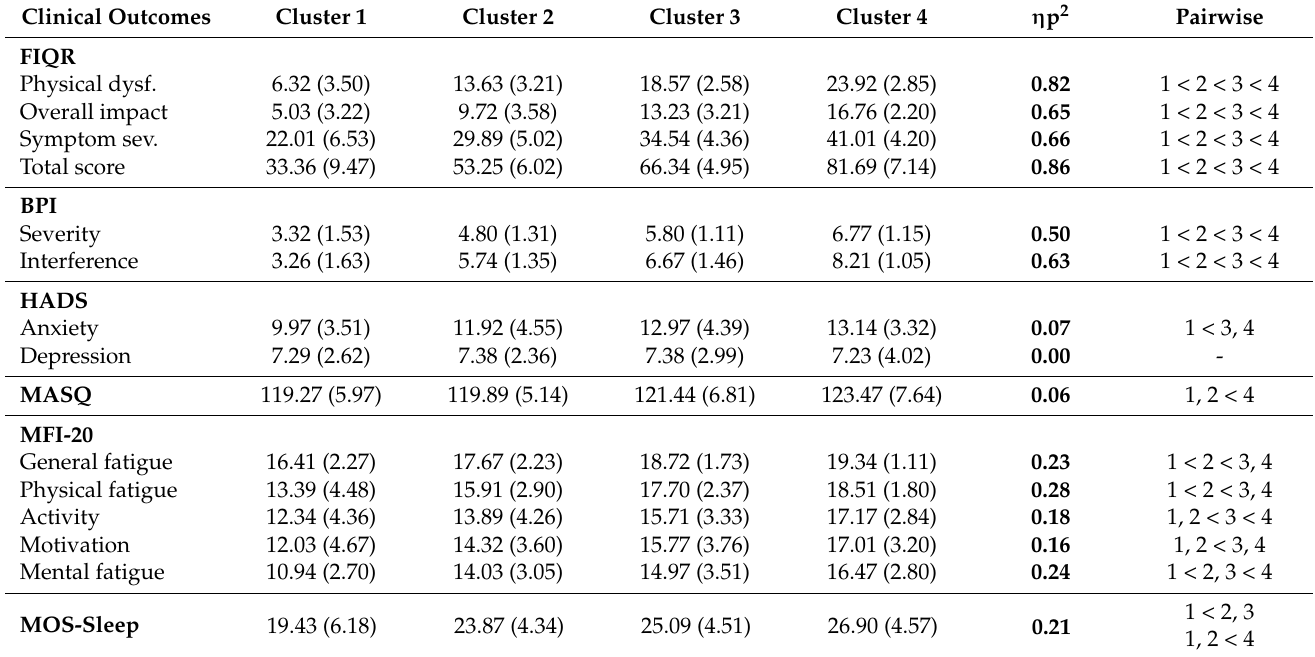
Table 2. Clinical outcomes per FIQR calculator-derived